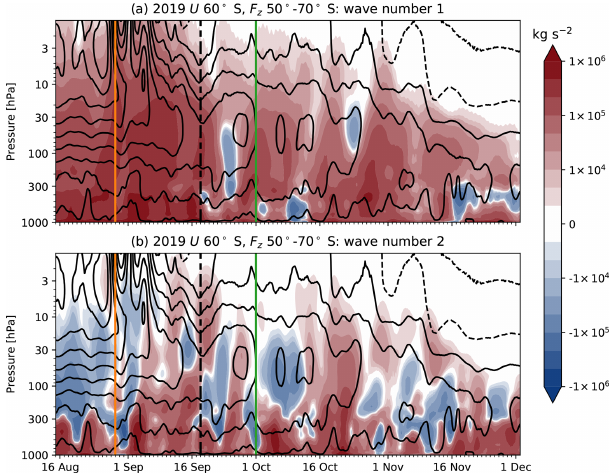
Figure 10. Wave forcing during the September 2019 austral mi- nor warming. Shading shows the vertical component of the Eliassen Palm flux averaged from 50–70 ◦ S from zonal wavenumber (a) one and (b) two. Contour lines show zonal-mean zonal wind at 60 ◦ S. The vertical dashed–dotted black line indicates the date of mini- mum zonal-mean zonal wind at 10hPa, 60 ◦ S. The vertical green and orange lines indicate the requested initialization